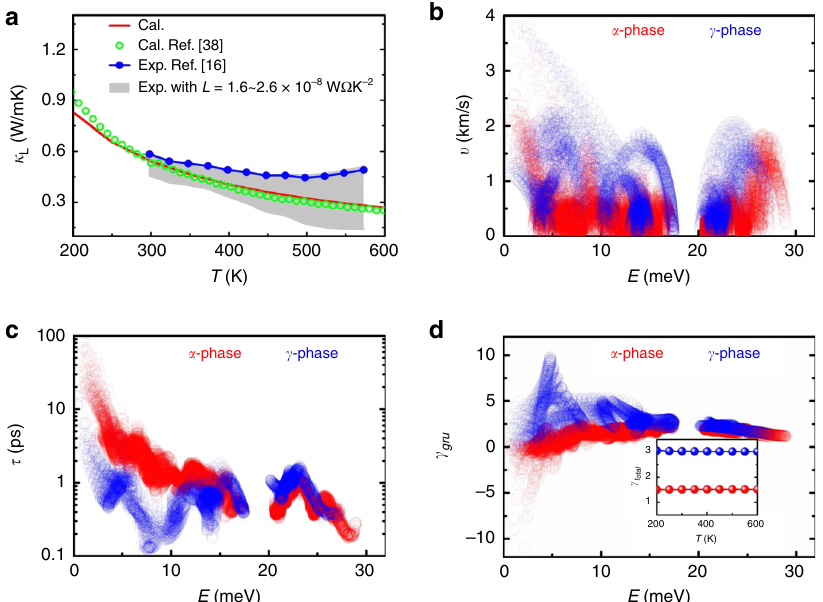
Fig. 5 Phonon transport properties in α -MgAgSb and in the high-symmetry structure MgAgSb (i.e., the γ -MgAgSb shown in Fig. 3f). a Experimental and theoretical temperature-dependent thermal conductivity of the α -MgAgSb phase. The literature values from ref. 38 (Cal.) and ref. 15 (Exp.) are also plotted for comparison. According to κ tot = κ lat + κ ele = κ lat + L σ T , the lattice thermal conductivity ( κ lat ) can be obtained by subtracting κ ele from the κ tot . The shadow regions are the experimental thermal conductivity of MgAg 0.97 Sb 0.99 with the Lorenz number 7,15 being from 1.6 to 2.6 × 10 − 8 W Ω K − 2 . Here, we only deal with the pure α -MgAgSb crystal and consider the phonon – phonon coupling to stimulate the phonon transport properties. Our calculated values are in excellent agreement with the previous reports and our measured values 15,38 . b Calculated phonon group velocities v , c phonon relaxation time τ , and d Grüneisen parameters γ α - and γ -MgAgSb at 300 K. The inset in d shows total γ gru for total obtained as a weighted sum of the mode contributions, as a function of temperature for α - and γ -MgAgSb. The γ gru of high values accumulate in the vicinity of 5 meV corresponding to the transverse acoustic phonon modes for γ